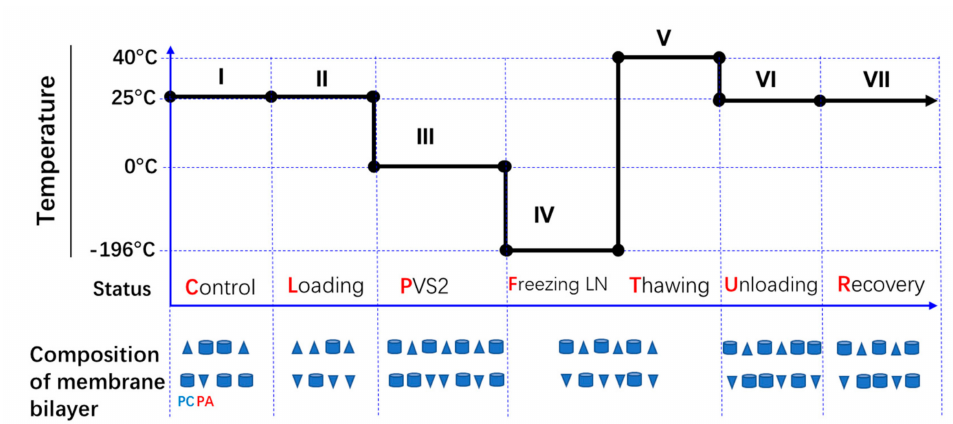
Figure 7. Schematic representation of membrane composition changes in Magnolia officinalis ECs during cryopreservation. The columns represent phosphatidylcholine (PC) and phos- phatidylethanolamine (PE), while the triangles represent phosphatidic acid (PA). The number of columns and triangles represents the total amount of